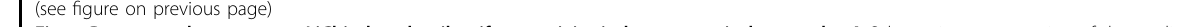
Fig. 5 Perampanel counteracts LiCl-induced epileptiform activity in human cortical networks. A Schematic representation of the applied protocol to evaluate the applicability of Perampanel to reverse LiCl-induced epileptiform activity in human iPSC-derived synchronously active cortical networks (day 20 – 50 after seeding). B , i Representative examples of MEA-recordings (three individual channels are shown) with their corresponding. B , ii Spike raster plot and population fi ring rate diagrams showing the suppression of LiCl-induced epileptiform population super-bursting by Perampanel. C , i The suppression of network parameters with increasing concentrations of Perampanel. The data are presented as mean ± standard deviation, n = 11, N = 2. One-way ANOVA with Tukey ’ s correction (comparison between the indicated groups) was applied to calculate the shown p values. C , ii Diagrams showing no change in network properties in the corresponding control experiments with equimolar NaCl and DMSO, n = 6, N = 2. D Cell-attached patch – clamp recording of human iPSC-derived cortical neuron, showing the increased spontaneous activity after the application of overdose concentration of LiCl (5 mM) and its suppression by Perampanel (2 µM). E Whole-cell patch – clamp traces showing the increased frequency of spontaneous EPSCs after the application of overdose concentration of LiCl (5 mM) and its suppression after the application of Perampanel (2 µM). The boxes mark regions of interest showed at higher magni fi cation below. PB population burst, PSB population super